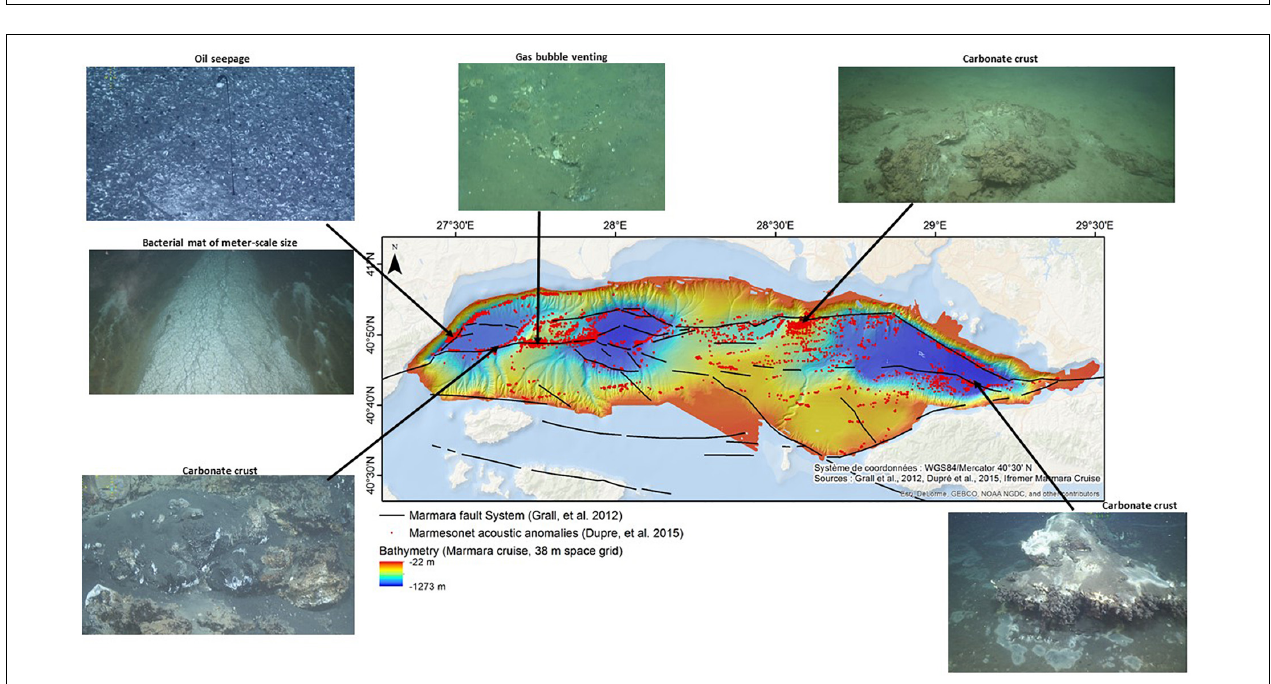
FIGURE 10 | Cross plots of B vs. Cl (A) and 87 Sr/ 86 Sr vs. Cl (B) of fluid endmembers from mud volcanoes in the Gulf of Cadiz and off Barbados compared to endmembers from different hydrothermal systems; Lost City, off-axis, serpentinization; Logatchev Field, ridge-crest, high temperature; Guaymas, sediment hosted, high temperature. Data from: Von Damm et al. (1985), Palmer (1991), Godón et al. (2004), Schmidt et al. (2007), Foustoukos et al. (2008), Scholz et al. (2009), Hensen et al. (2015) and Seyfried et al. (2015).